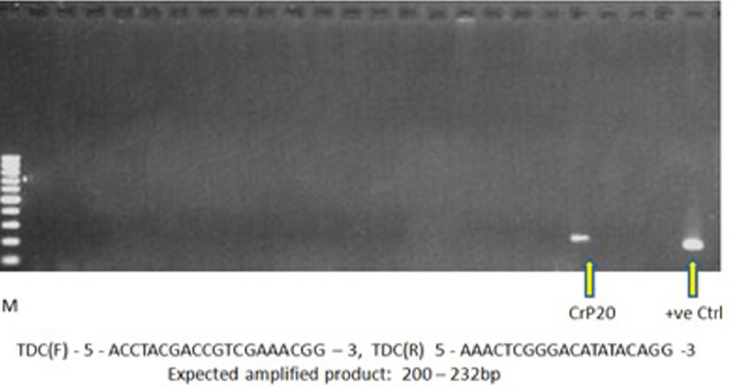
Fig 5. Genomic PCR analyses to determine the presence of the TDC gene. Lane M: 100-bp ladder; Lanes 1 – 22: the PCR amplification products of the TDC gene in 22 endophytic fungal isolates. Arrowheads show the amplified products in T . radicus — CrP20 and C . roseus (which served as the positive